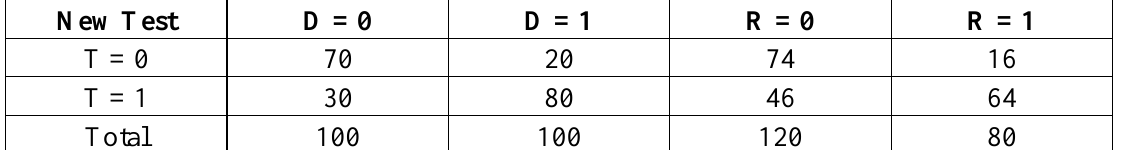
Table 18. Hypothetical example imperfect